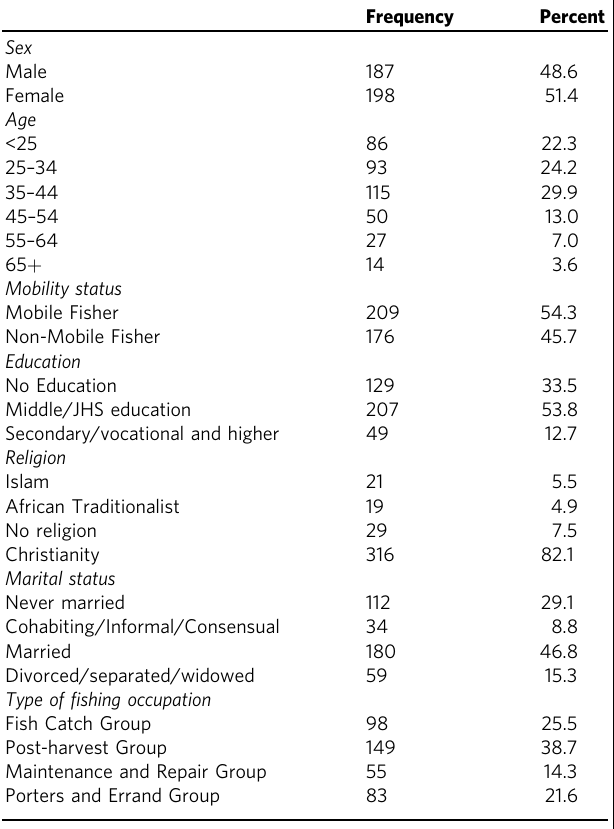
Table 2 Socio-demographic characteristics of respondents. Table 3 Knowledge of HIV education programs in the last 12